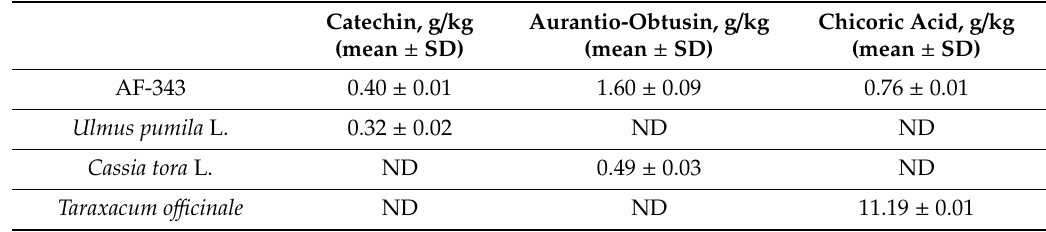
Table 1. Content of catechin, aurantio-obtusin, and chicoric acid in AF-343 and extracts of Ulmus pumila L., Cassia tora L., and Taraxacum o ffi cinale . Catechin, g / kg Aurantio-Obtusin, g / kg Chicoric Acid, g / kg (mean ± SD) (mean ± SD) (mean ± SD) AF-343 0.40 ± 0.01 1.60 ± 0.09 0.76 ± 0.01 Ulmus pumila L. 0.32 ± 0.02 ND ND Cassia tora L. ND 0.49 ± 0.03 ND Taraxacum o ffi cinale ND ND 11.19 ± 0.01 ND, not